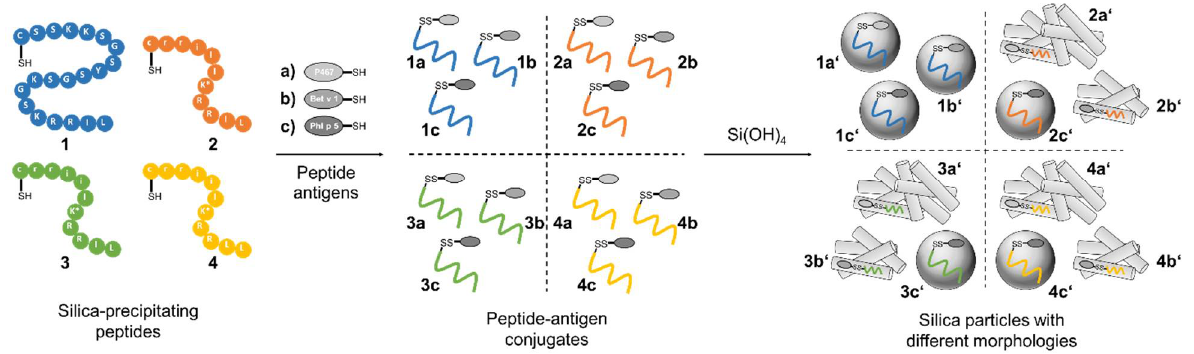
Figure 4. Conjugation of four silica-precipitating peptides (CysR5 1 , RRIL-1 2 , RRIL-2 3 and RRLL 4 ) to three peptide antigens (P467 a , Bet v 1 b , and Phl p 5 c ) via disulfide bond formation. Addition of silicic acid leads to the formation of 12 different peptide–antigen silica particles with different morphologies including spheres, rods, and interwoven networks. CysR5-related structures are displayed in blue, RRIL-1-related structures in orange, RRIL-2-related structures in green and RRLL- related structures in yellow.